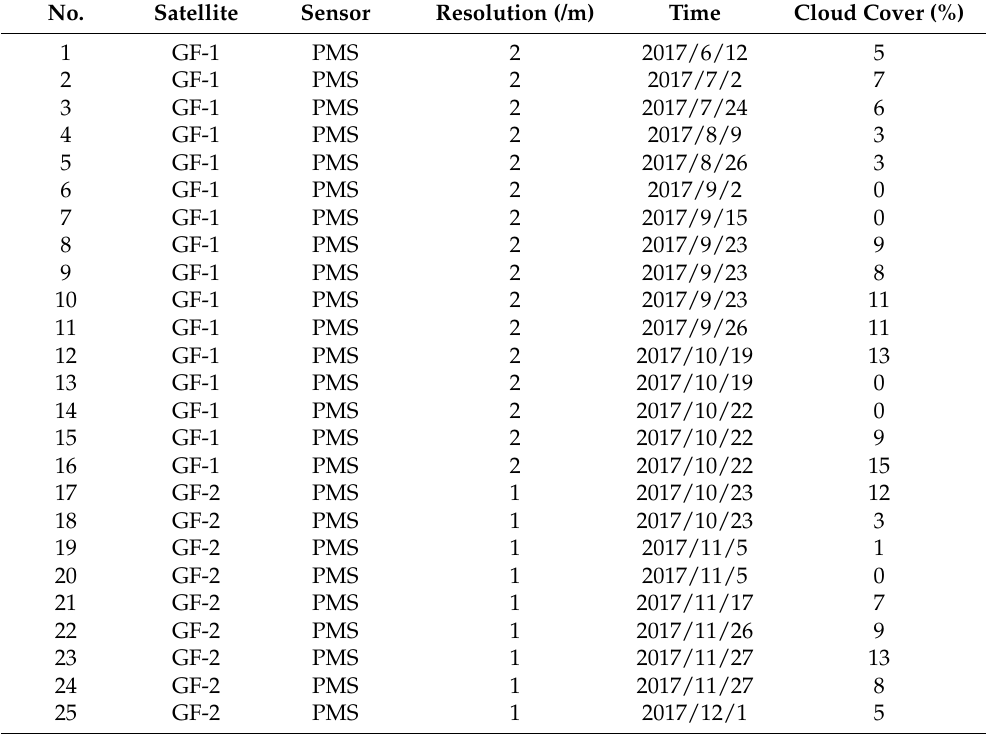
Table 1. The GF-1/2 remote sensing image data (PMS = particular matter sensor).